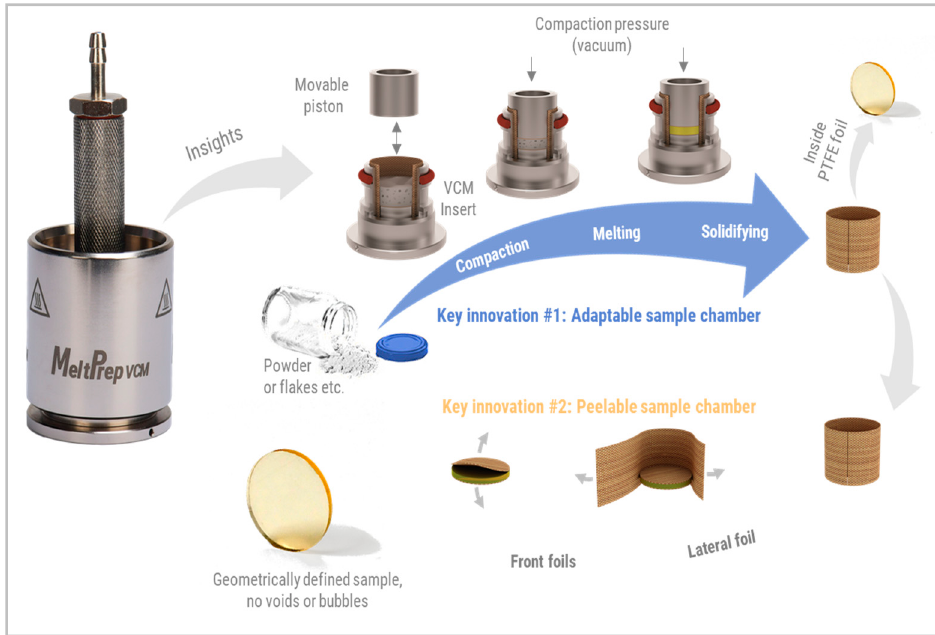
Figure 1. MeltPrep ® Vacuum Compression Molding (VCM) process.